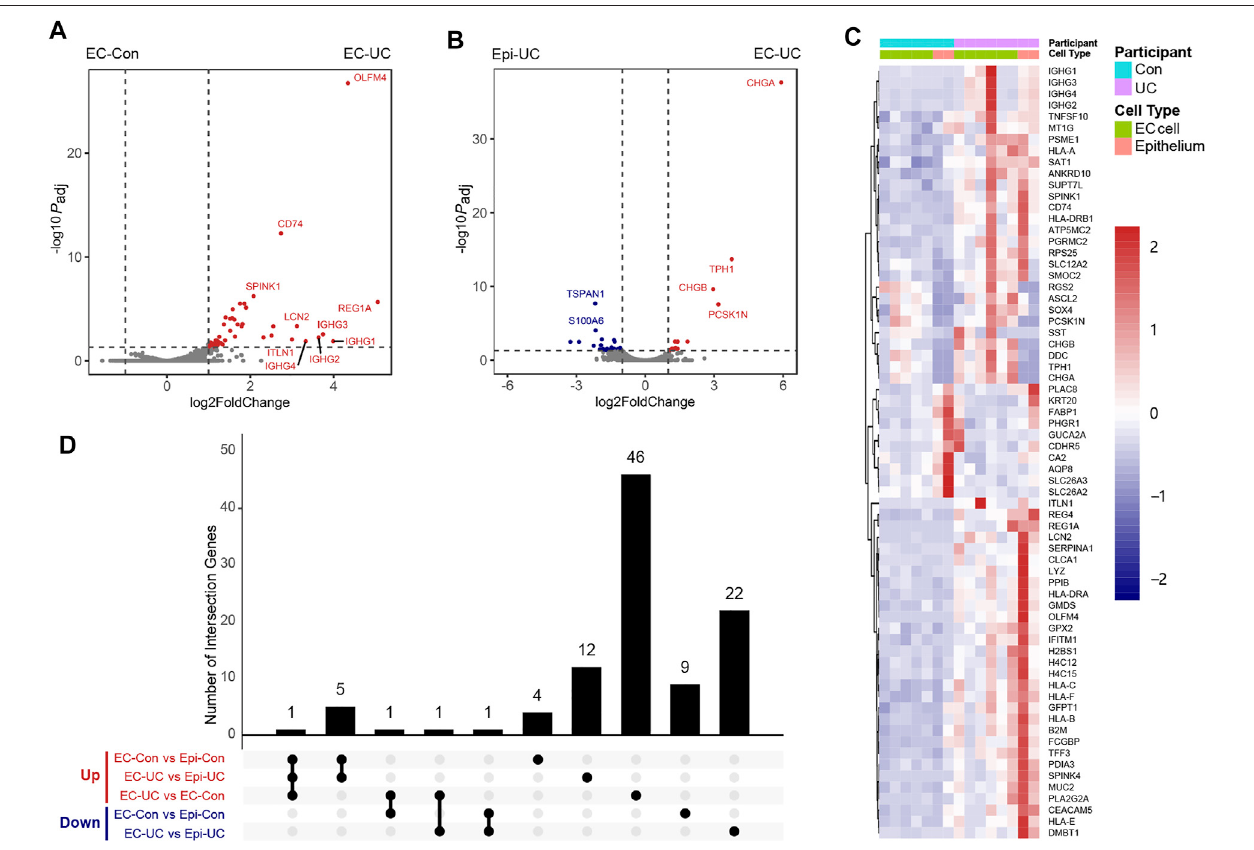
FIGURE 4 | DEG analysis of EC cells in patients with ulcerative colitis. (A) Comparison of the transcriptomes of EC cells between patients with UC and controls. Verticaldottedlinesrepresentlog2FoldChangevaluesof1and − 1.Thehorizontaldottedlinerepresentsadjusted P =0.05. P adj ,adjusted p -value. (B) Comparisonofthe transcriptomesofECcellsandbackgroundepitheliuminpatientswithUC. (C) Overallheatmapofgenesidenti fi edinDEGanalyses(EC-Convs.Epi-Con,EC-UCvs.Epi- UC, and EC-UC vs. EC-Con). (D) Overlap of DEGs identi fi ed in the three analyses mentioned above. The upregulation (Up, in red) and downregulation (Down, in blue) of DEGs was shown, respectively. No genes were downregulated in EC-UC compared to EC-Con.